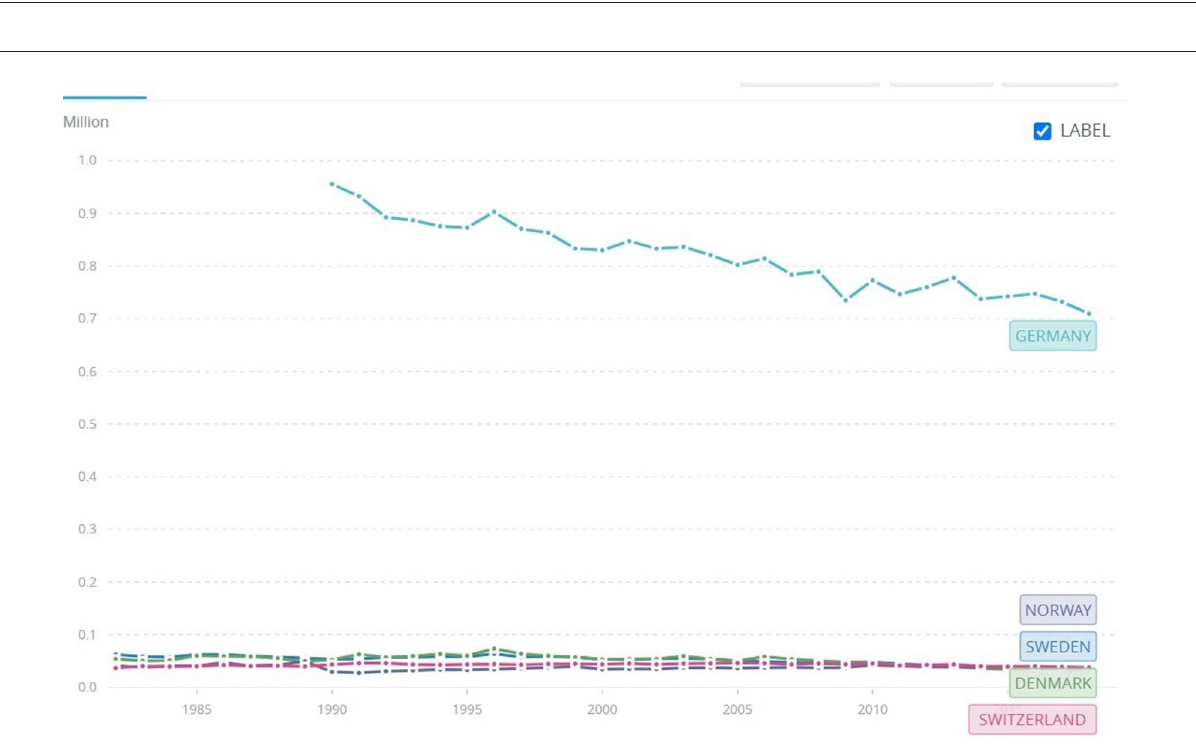
FIGURE7 Exemplary nation-states. CO2 emissions since the 1980s. Source: World Bank. At https://data.worldbank.org/indicator/EN.ATM.CO2E.KT? locations=RU-CN-US (accessed February 26,